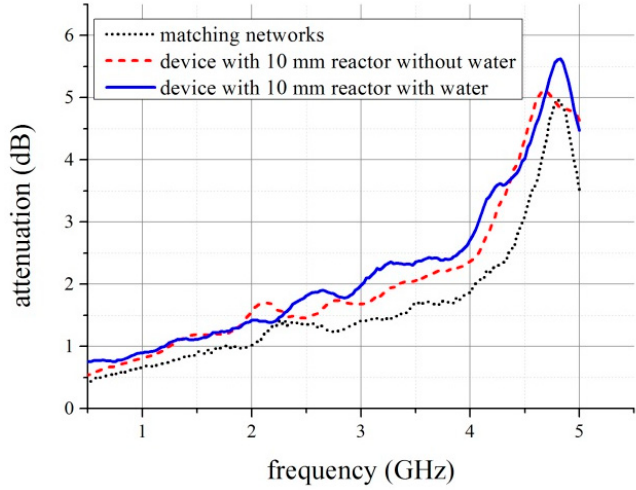
Figure 8. Measured attenuation of the device with and without water.